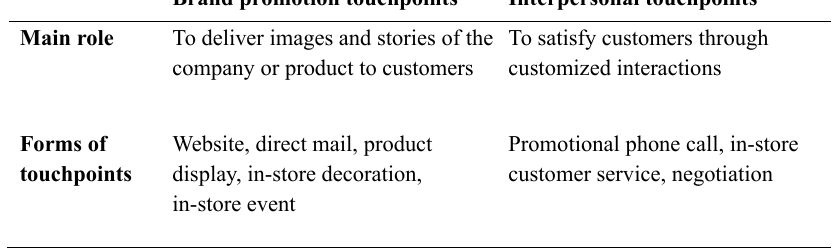
Table 1. Company X’s